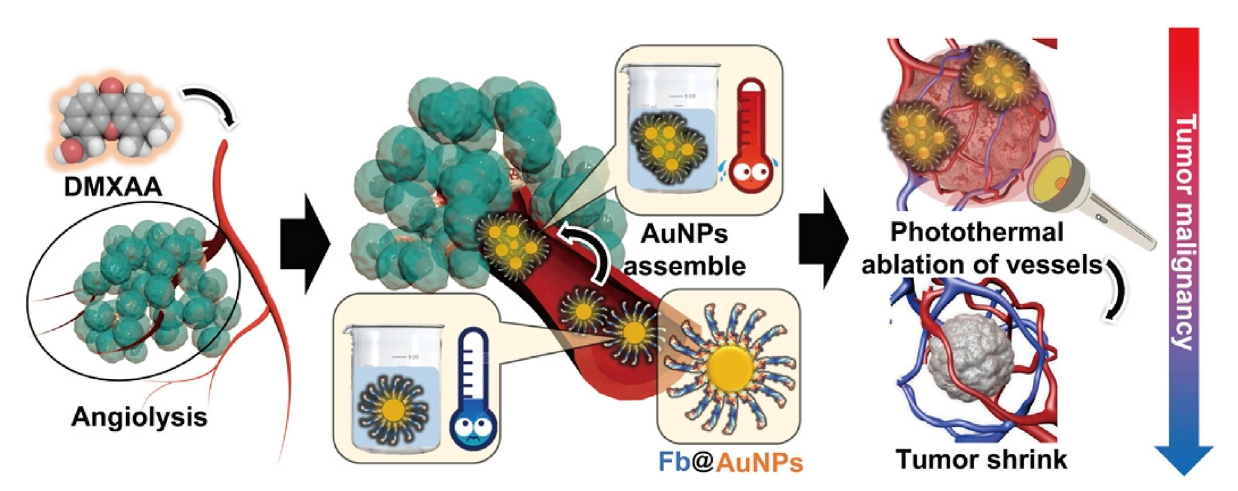
FIGURE 2 TheDMXAAtreatmentdisruptstumorvesselsandsubsequentlyinducesAuNPsaggregationinthetumorvessels.Afterward,near-infraredirradiation is applied to achieve the combination of VDAs with PTT for peTVD and photothermally ablate the tumor vascular. Fb, fi brinogen (Hong et al., 2020). Copyright © 2020,